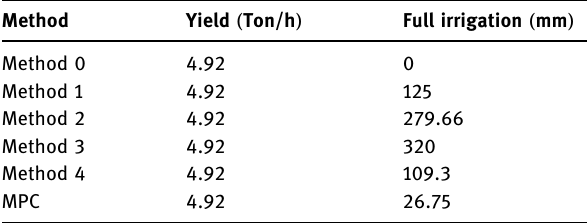
Table 3: Yield and total irrigation for the Year 2020